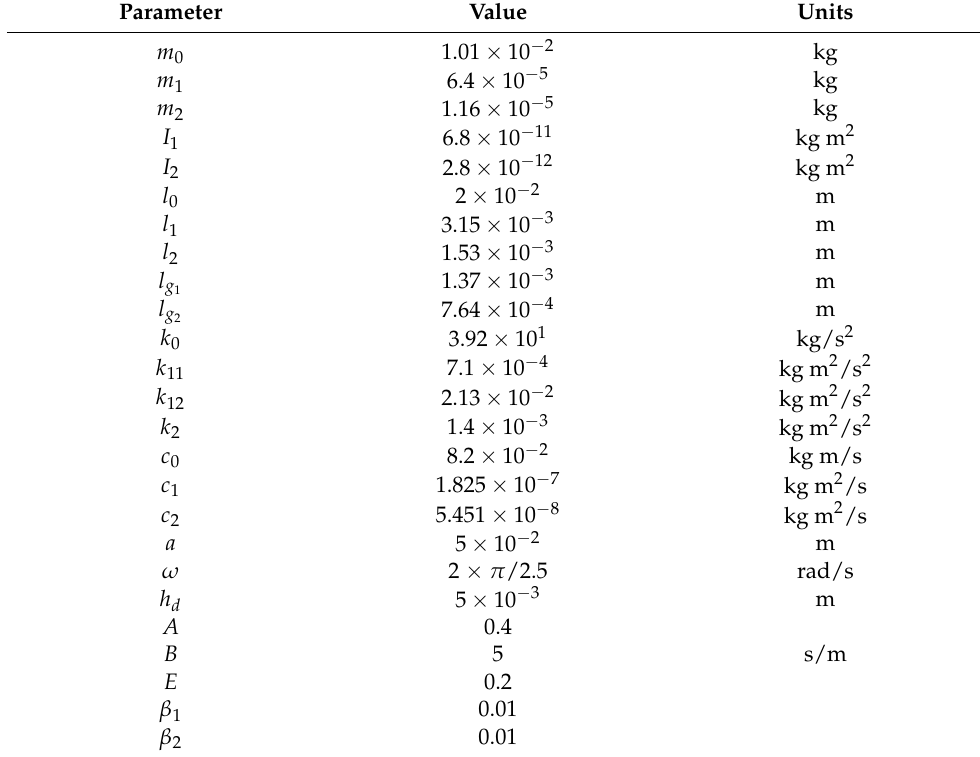
Table 1. Parameters and values used in the